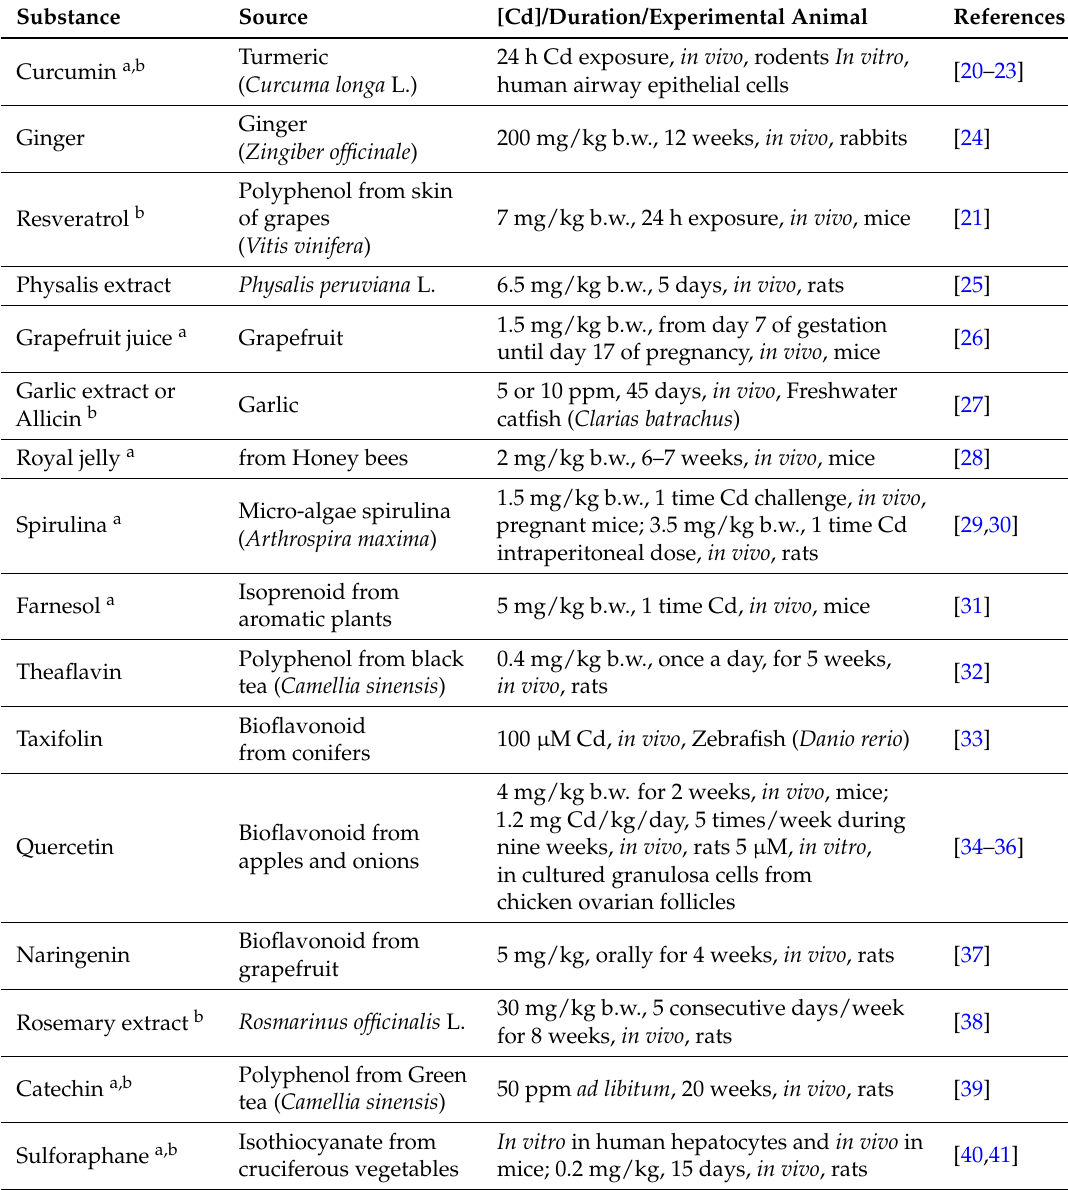
Table 1. Protective natural compounds and phytochemicals against Cd